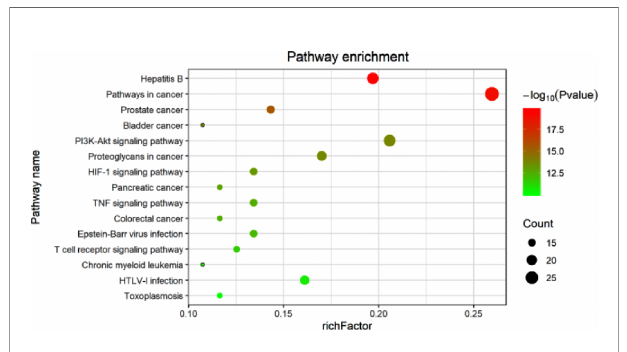
FIGURE 6 | KEGG pathway analysis for